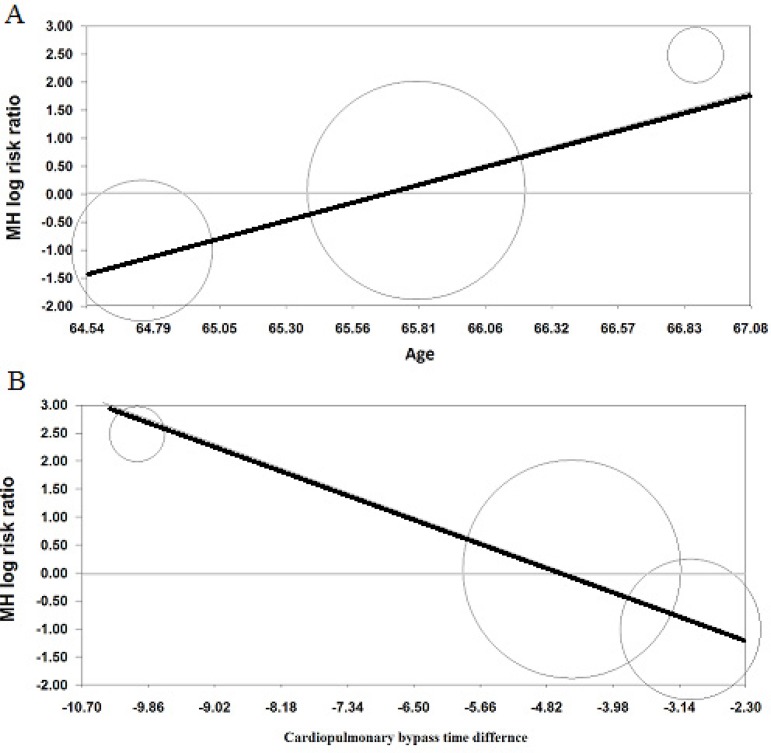
(A) Plot of MH log RR against age. Values in the horizontal line represent mean age in individual studies. Negative values in vertical axis favor the neuroprotective effect of low MAP (below the horizontal gray line). (B) Plot of MH log RR against CPB time difference. Negative values in horizontal axis indicate a longer mean CPB time for the low MAP group (CPB time difference=high MAP – low MAP). Negative values in vertical axis favor the neuroprotective effect of low MAP (below the horizontal gray line).